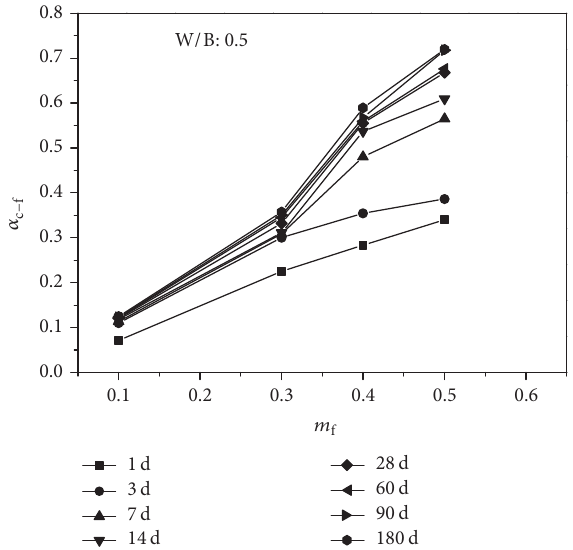
Figure 9: Influence of the fly ash content on the increased degree of cement